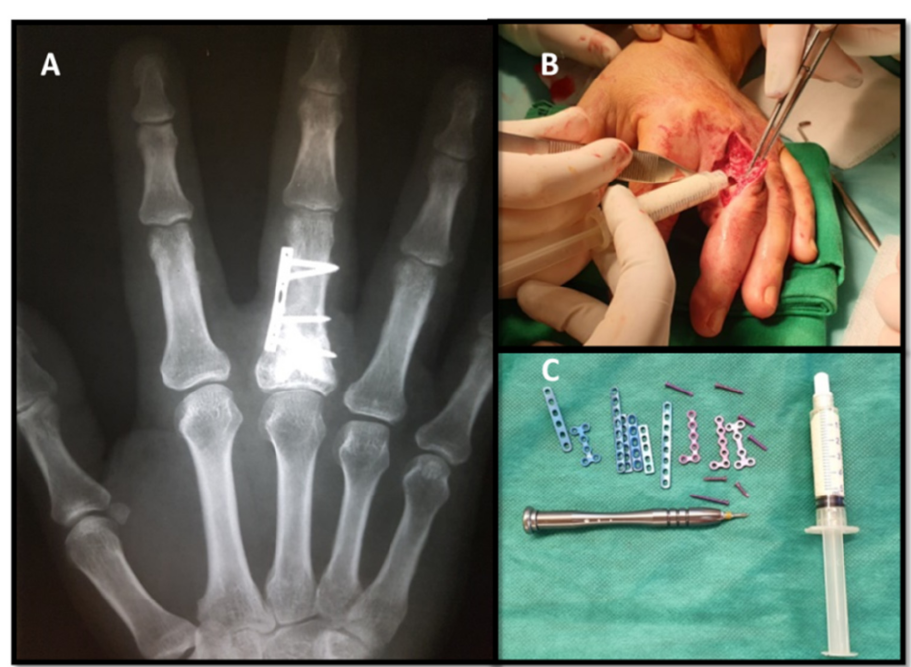
Figure 2. Enchondroma of the first phalanx treated by curettage and injectable bone substitute. ( A )— Immediate postoperative aspect of bone defect filled with injectable bone substitute and miniplate, ( B )—Intraoperative application of k-IBS ® substitute, ( C )—miniplate-kit and prefilled ready-to-use syringe with bone